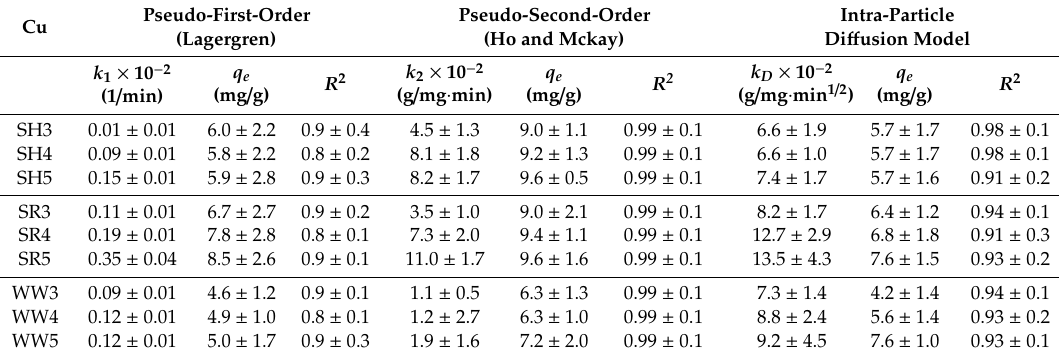
Table 2. Parameters of the Cu adsorption kinetics calculated on the basis of the kinetic models with standard deviations ( n = 3): SH3 (sunflower husks, 300 ◦ C), SH4 (sunflower husks, 400 ◦ C), SH5 (sunflower husks, 500 ◦ C), SR3 (sunflower husks + rapeseed pomace, 300 ◦ C), SR4 (sunflower husks